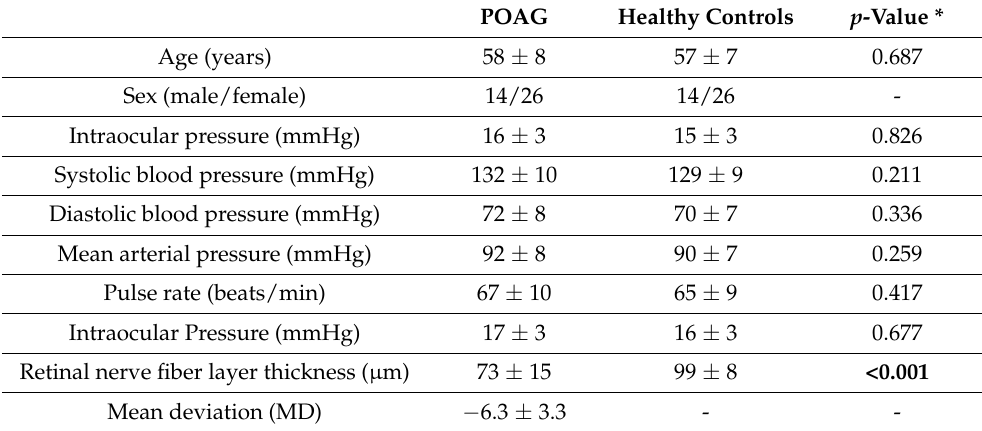
Table 1. Characteristics of glaucoma patients and matched